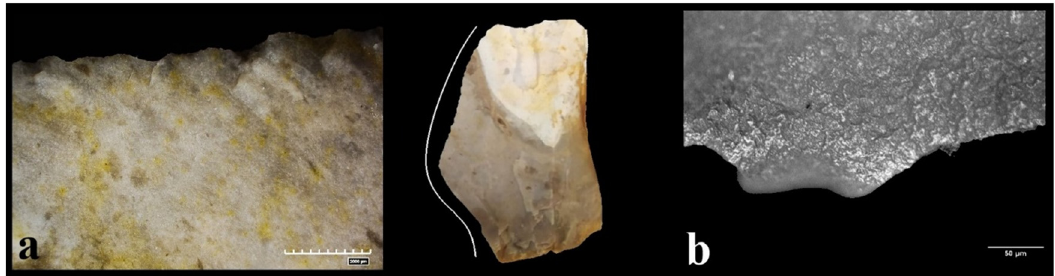
Figure 5: ( a ) Edge rounding and macro traces and ( b ) granular polish after 1.5 h of work ( photo A. Petrovi ć )